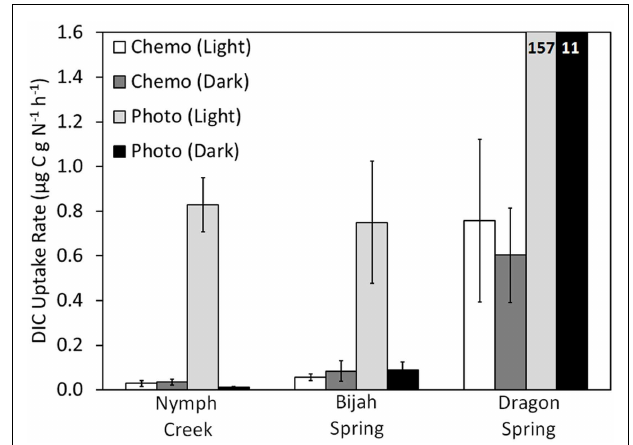
FIGURE 4 | Rate of DIC uptake for chemotrophic and phototrophic assemblages sampled from adjacent sides of the photosynthetic fringe in Nymph Creek (fringe pH = 2.99,Temp. = 52.7˚C), Bijah Spring (fringe pH = 7.40,Temp. = 70.0˚C), and Dragon Spring (fringe pH = 2.95, Temp. = 46.5˚C). Microcosms were incubated both in the light and the dark and rates reflect the difference between triplicate killed controls and triplicate biological controls, for each treatment. For comparative purposes, DIC uptake rates were normalized to grams organic nitrogen present in the chemotrophic or phototrophic biomass used as inoculum ( Table 1 ). All spring water used in the microcosms was sampled from the photosynthetic fringe and all microcosms were incubated in situ at the photosynthetic fringe temperature. Rates of DIC uptake for the phototrophic assemblages sampled from Dragon Spring are indicated as insets on the